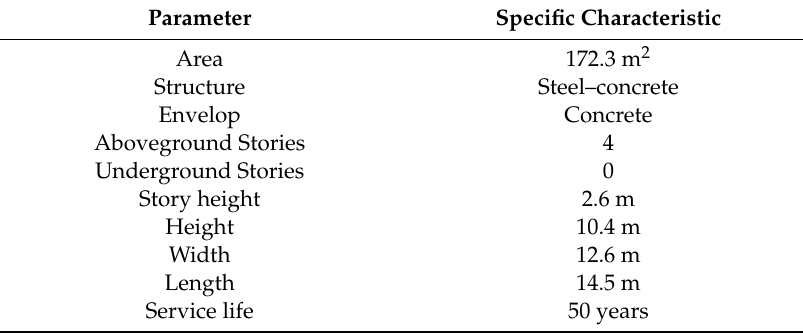
Table 1. Building